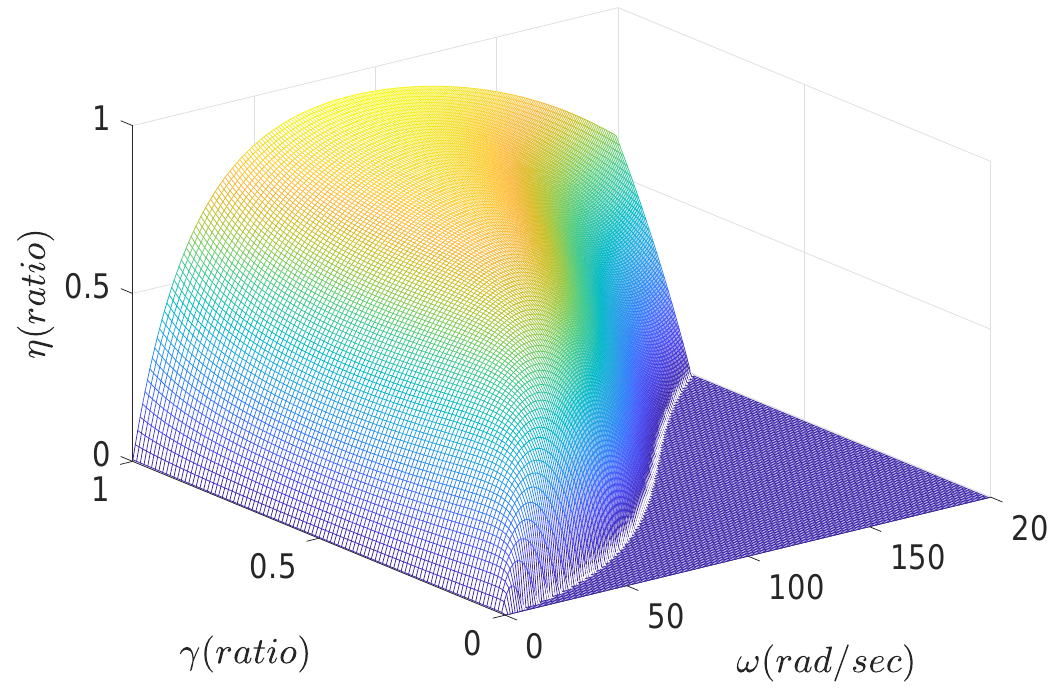
Figure 7. η ( γ , ω , H , D ) where negative values are set to zero.